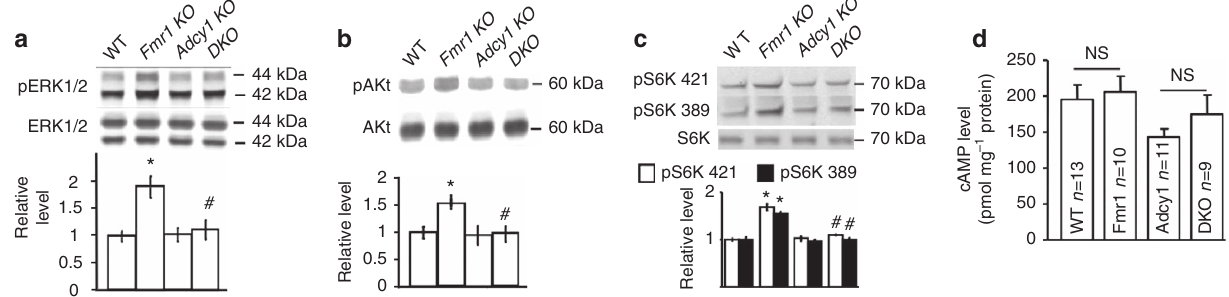
Figure 2 | Genetic removal of Adcy1 normalizes aberrant neuronal signalling in Fmr1 KO hippocampus. The levels of phosphorylated and total ERK1/2 ( a ), Akt ( b ) and S6K1 ( c ) in the hippocampus of WT, Fmr1 KO, Adcy1 KO and DKO mice ( n ¼ 6 per group) were determined by immunoblot. Representative immunoblot results are shown in the top panels, and quantifications are shown in the bottom panels. ( d ) The level of cAMP in the hippocampus of WT, Fmr1 KO, Adcy1 KO and DKO mice was determined by ELISA. *: significant difference between WTand Fmr1 KO group ( P ¼ 0.021 in a; P ¼ 0.033 in b ; P ¼ 0.037 and 0.036 for pS6K421 and pS6K389, respectively, in c ). # : significant difference between Fmr1 KO and DKO group ( P ¼ 0.028 in a ; P ¼ 0.026 in b ; P ¼ 0.033 and 0.031 for pS6K421 and pS6K389, respectively, in c ). The P -values were determined by post-hoc LSD test following ANOVA analysis ( n ¼ 6 for each group; F 3,20 ¼ 5.354, P ¼ 0.009 in a ; F 3,20 ¼ 4.662, P ¼ 0.02 in b ; F 3,20 ¼ 3.525, P ¼ 0.029 for pS6K421 and F 3,20 ¼ 3.747, P ¼ 0.027